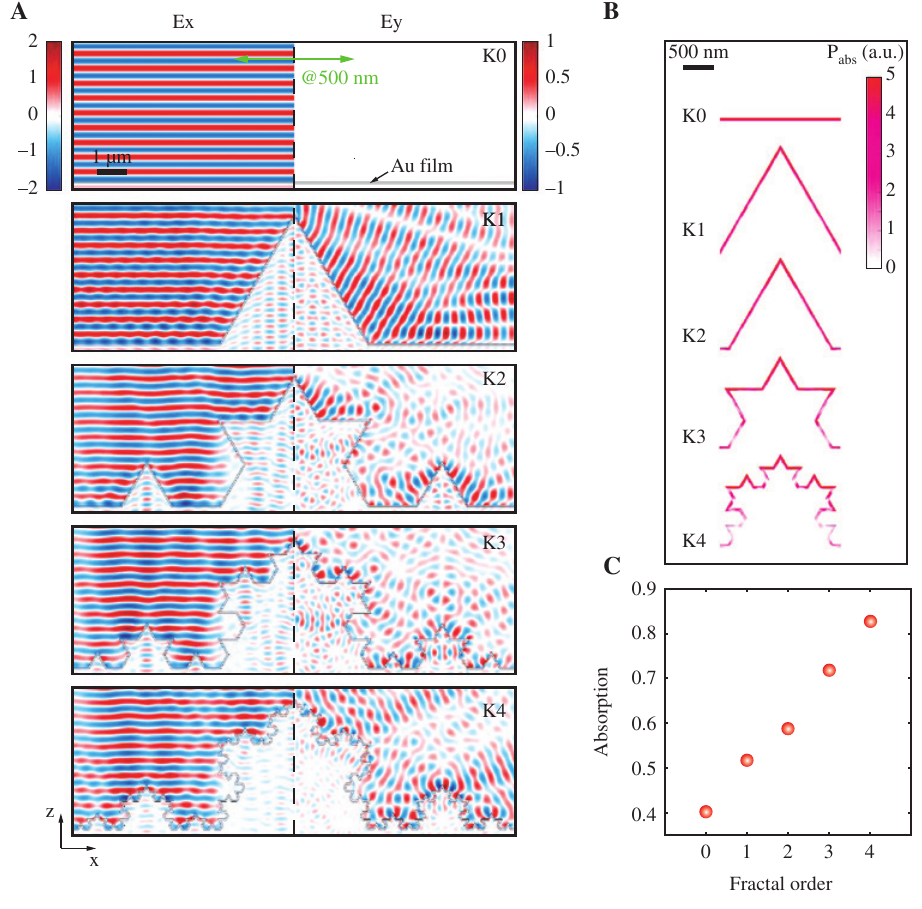
Figure 3: Spatial characterisation of the fractal structures. (A) Electric field distribution in the x–z plane. E polarisation of the electric field at λ = 500 nm. (B) The absorption power density P region is selected around x = 0. (C) The relationship between the absorption and fractal order at λ = 500 nm.